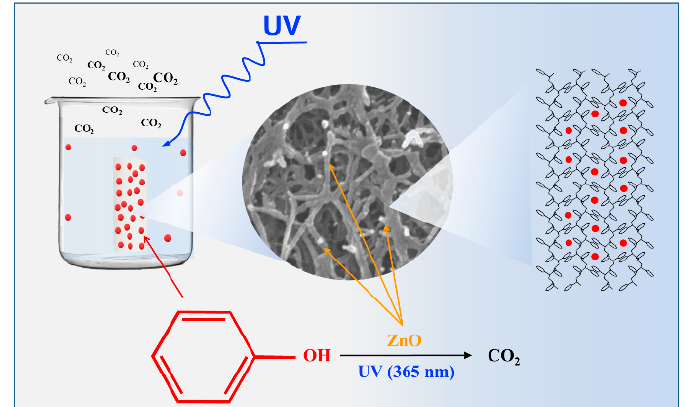
Figure 4. Scheme of the phenol sorption and photocatalysis within the ZnO/s-PS aerogels characterized by the nanoporous δ -form.